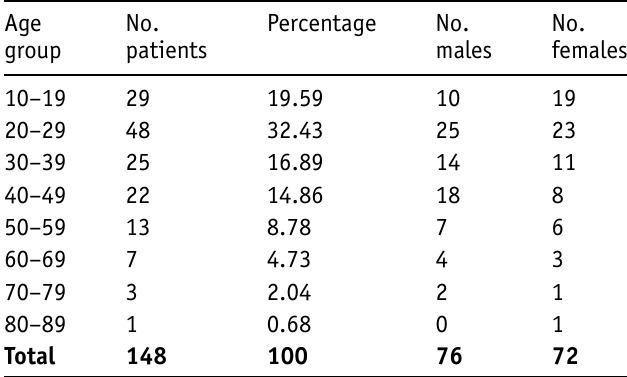
Table I. Age and gender distribution of ameloblastoma within this